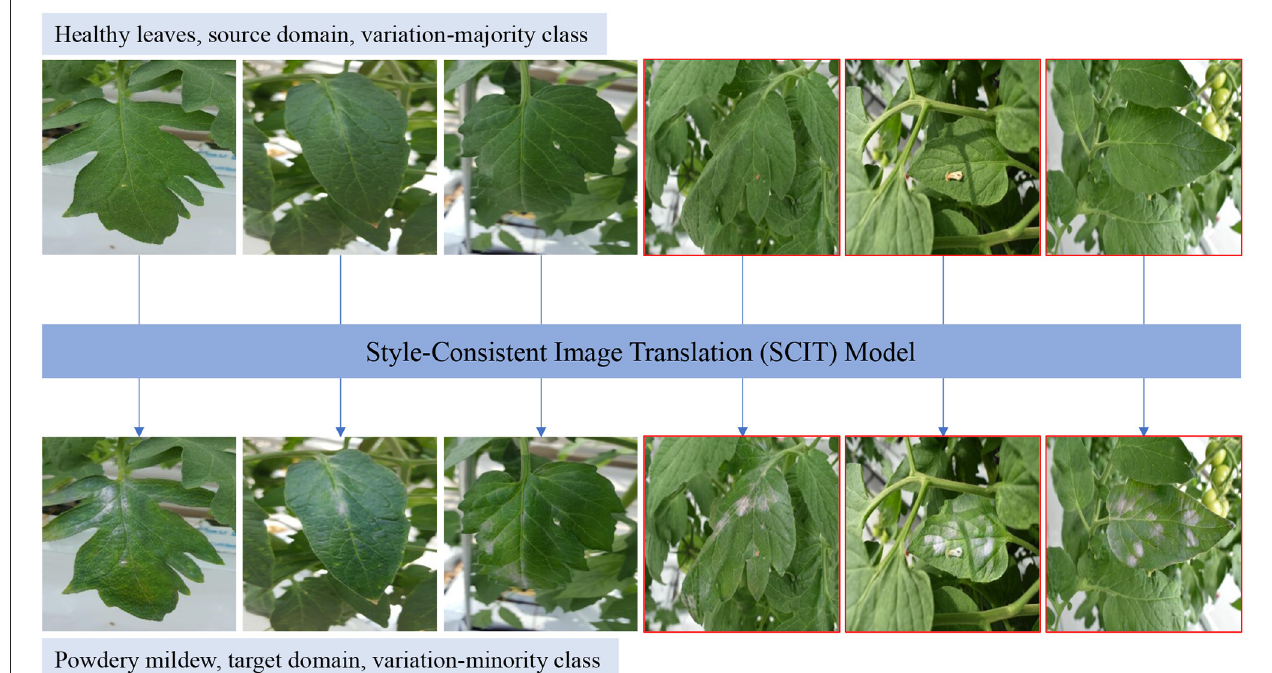
FIGURE 1 | Data augmentation from healthy tomato leaves to powdery mildew leaves using the proposed style-consistent image translation (SCIT) model. Healthy leaves are in the source domain, belonging to the variation-majority class, while powdery mildew leaves are in the target domain, belonging to the variation-minority class. Ours SCIT model is leveraged to translate the images in the source domain into the target domain, which can take the variations from the variation-majority class to the variation-minority class. Healthy leaves include several variations, background, type of tomato, viewpoint, shape, illumination, size. SCIT model can only translate one given leaf in one image as shown right three images with red boundary, compared to other generative adversarial networks (GAN)-based data augmentation methods which translate all leaves in one image (Cap et al., 2020; Nazki et al.,